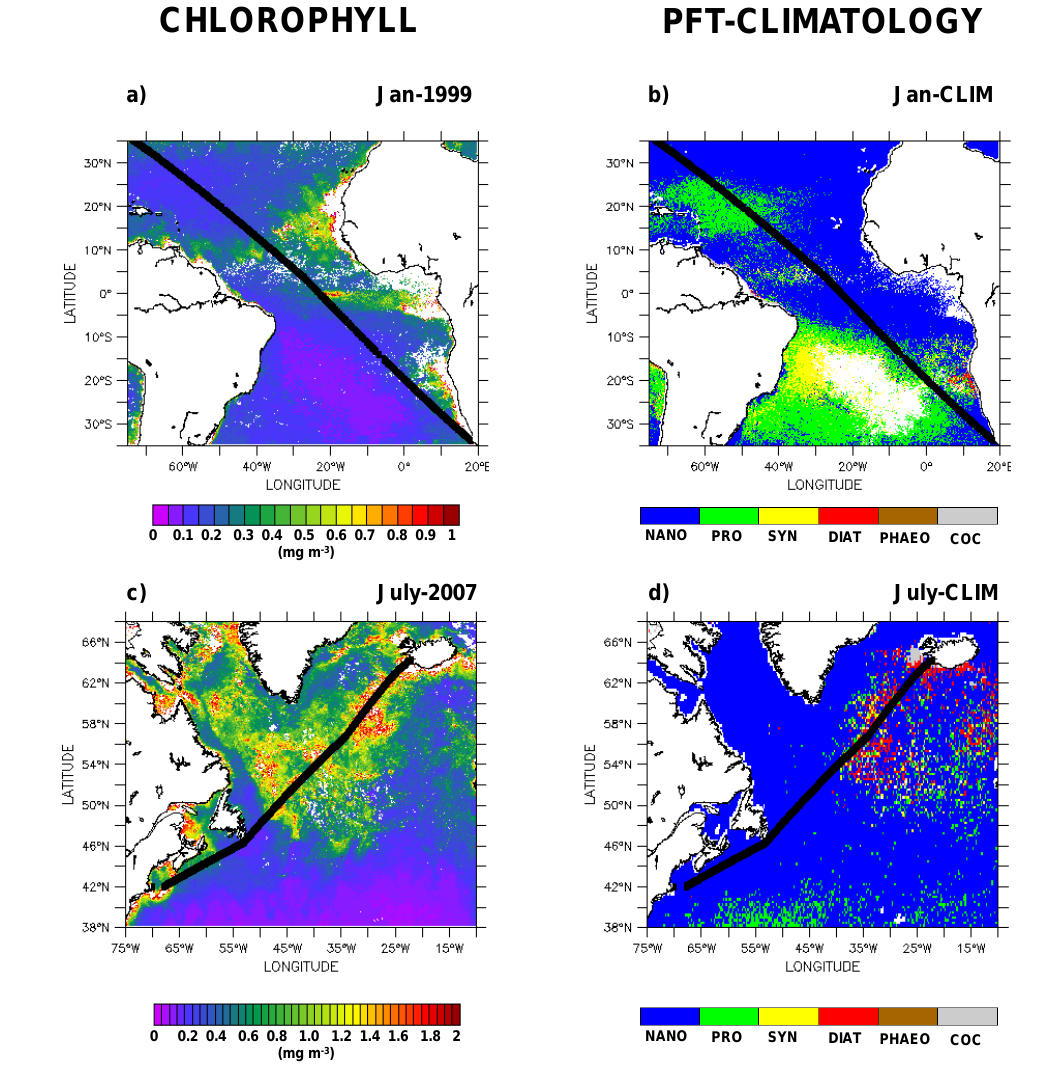
Fig. 3. Same as Fig. 2 but for the Atlantic Ocean. (a, b) North and South Atlantic, (c, d) western North Atlantic.